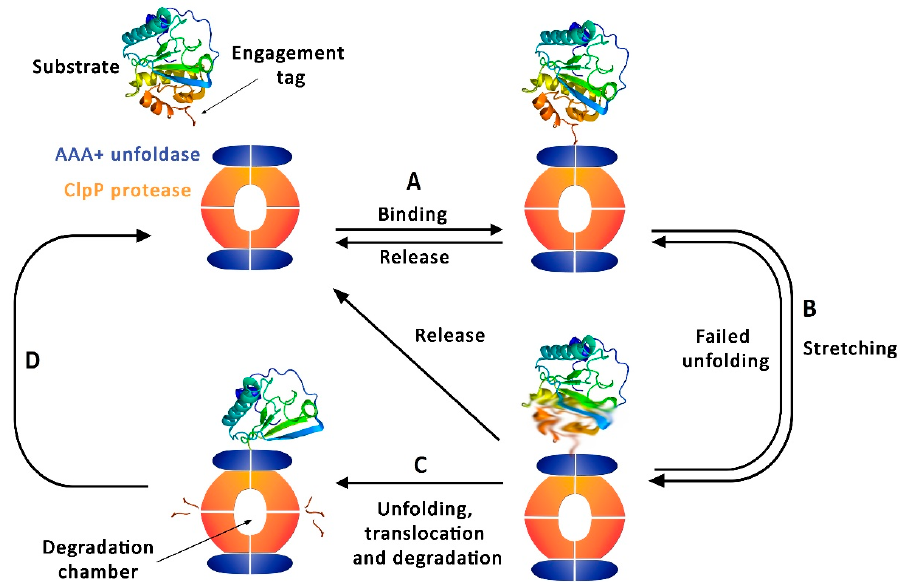
Figure 1. Cycle of ATPases associated with diverse cellular activities (AAA + ) caseinolytic protease proteolytic subunit (ClpP) complex. ( A ) Substrate selective binding by the AAA + unfoldase. ( B ) Sequence of ATP-driven stretching, leading to a strained structure or alternatively to a substrate release. ( C ) Successful unfolding leading to translocations and degradation. ( D ) Initiation of a new